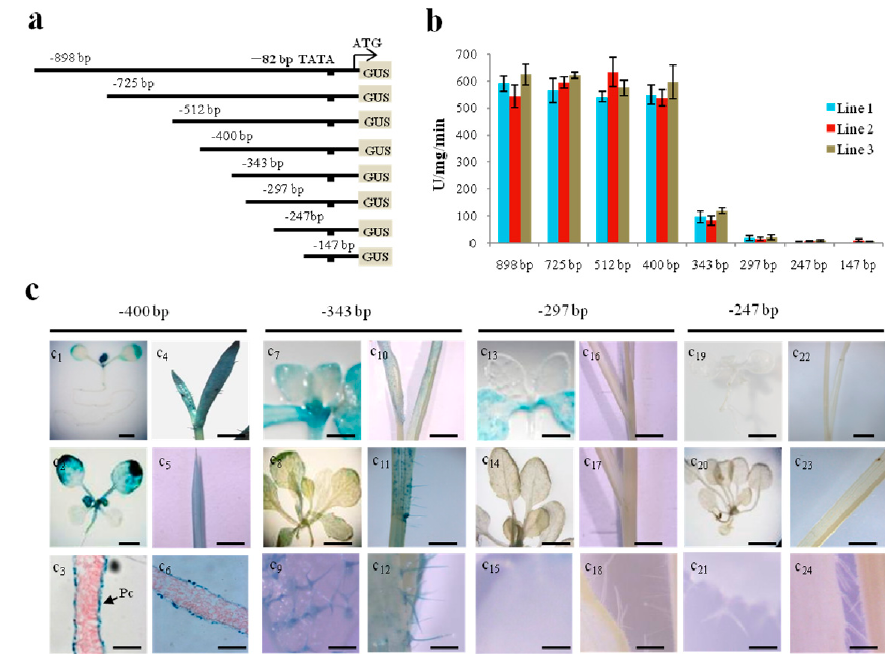
Figure 1. Activities of a TaLTP1 promoter deletion series in transgenic A. thaliana and B. distachyon. ( a ) Each of the 5’upstream fragments from the TaLTP1 promoter was fused to the translational start site of beta-glucuronidase reporter gene; ( b ) Quantitative GUS activity of two-week-old T 3 transgenic A. thaliana seedlings with TaLTP1 promoter deletions. 4-MUG was used as substrate in the assay. Three replicates for each transgenic line were done; each replicate contained at least 5 seedlings; ( c ) GUS activity of A. thaliana transformed with pBI121 vector harboring − 400 TaLTP1::uidA (c 1 –c 3 ) , − 343 TaLTP1::uidA (c 7 –c 9 ), − 297 TaLTP1::uidA (c 13 –c 15 ), − 247 TaLTP1::uidA (c 19 –c 21 ), GUS activity of B.